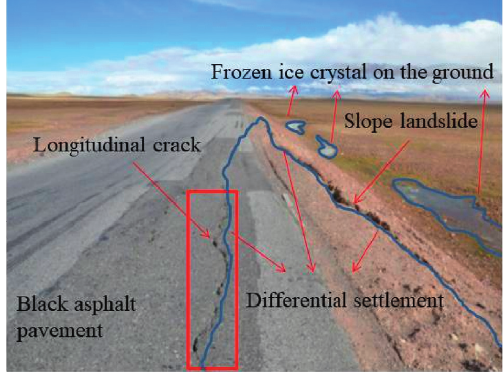
Figure 1: Typical damage resulting from a frozen soil